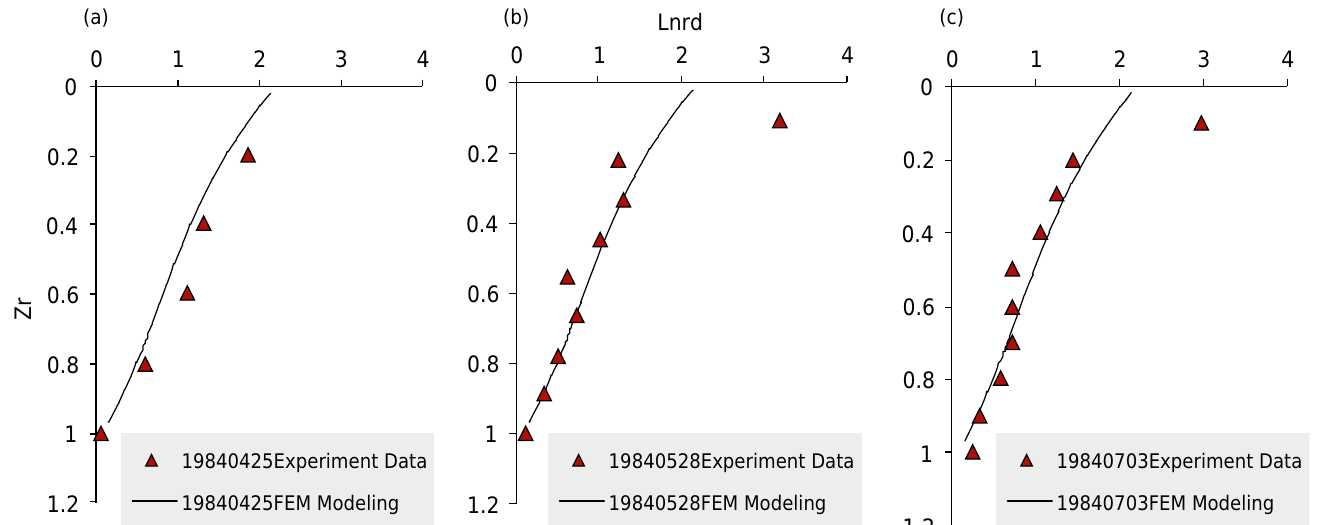
Figure 4. Comparison of normalized root length distribution between measurement and